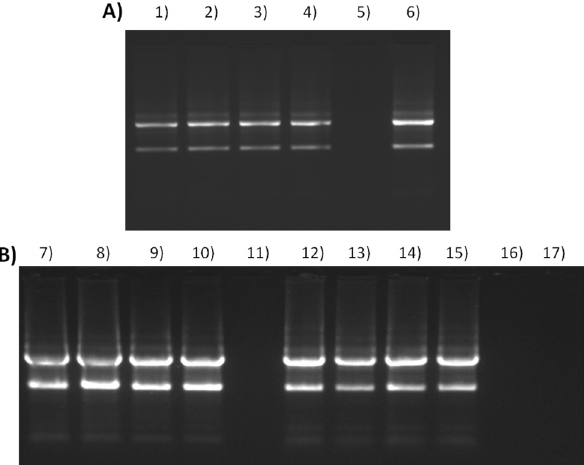
Figure 5. RNA integrity analysis. ( A ) Post-isolation spiked samples. ( B ) Co-isolation spiked samples. Lanes: ( 1 ) RNA untreated control. ( 2 ) RNA untreated control with RNAProtect solution + 25% AuNP-spike. ( 3 ) RNA untreated control with RNAProtect solution + 50% AuNP-spike. ( 4 ) RNA untreated control with RNAProtect solution + 75% AuNP-spike. ( 5 ) AuNP (3 nM) with 6xOrange Loading dye (Fermentas). ( 6 ) The 24 h AuNP-treated RNA with RNAProtect solution. ( 7 ) RNA untreated control. ( 8 ) RNA untreated control + 25 m L AuNP-spike. ( 9 ) RNA untreated control + 50 m L AuNP-spike. ( 10 ) RNA untreated control + 100 m L AuNP-spike. ( 11 ) Unloaded lane. ( 12 ) RNA untreated control with RNAProtect solution ( 13 ) RNA untreated control with RNAProtect solution + 25 m L AuNP-spike. ( 14 ) RNA untreated control with RNAProtect solution + 50 m L AuNP-spike. ( 15 ) RNA untreated control with RNAProtect solution + 100 m L AuNP-spike. ( 16 ) Unloaded lane. ( 17 ) AuNP (3 nM) with 6xOrange Loading dye (Fermentas).